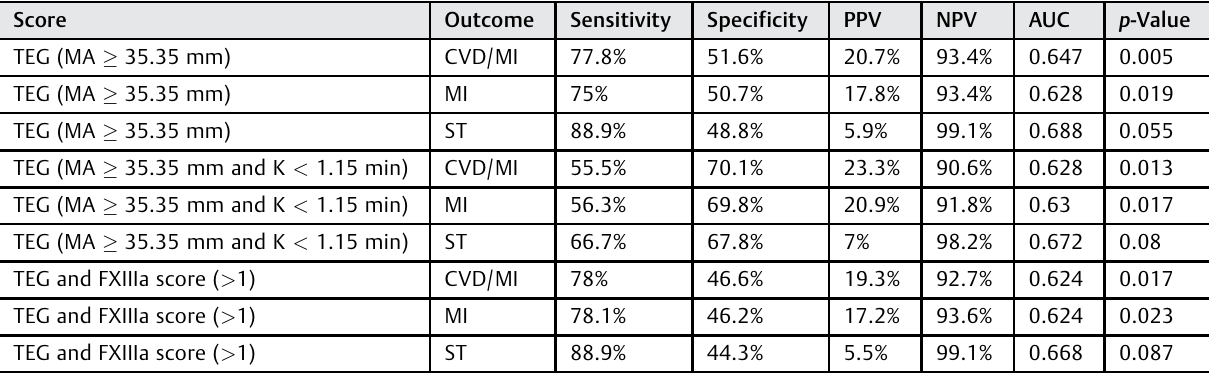
Table 7 Sensitivity, speci fi city, PPV, NPV, and c-statistic for high TEG-MA, combination of high TEG-MA/low TEG-K, and combined TEG MA/K/FXIIIa score for CVD, MI, and possible/probable/de fi nite ST Score Outcome Sensitivity